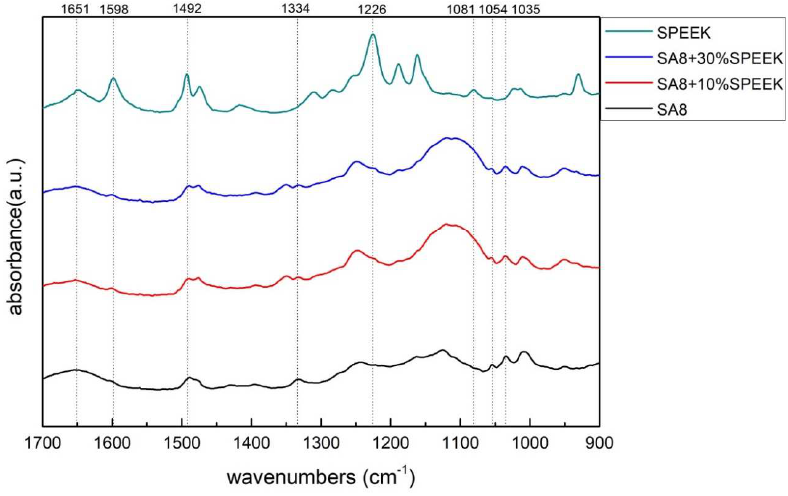
Figure 8. FT-IR spectra of SA8 blended with sPEEK series at 1700–900 cm −1 .